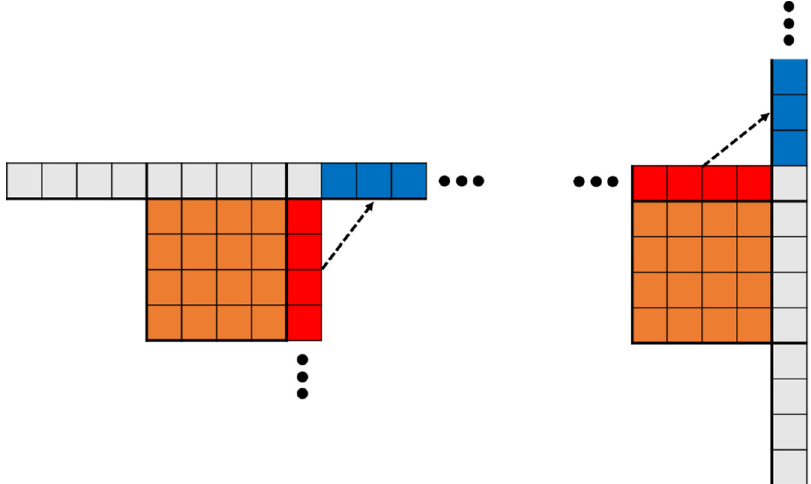
Figure 7. Extrapolation for the vertical directional modes ( left ) and the horizontal directional modes ( right ) in the horizontal reference set.